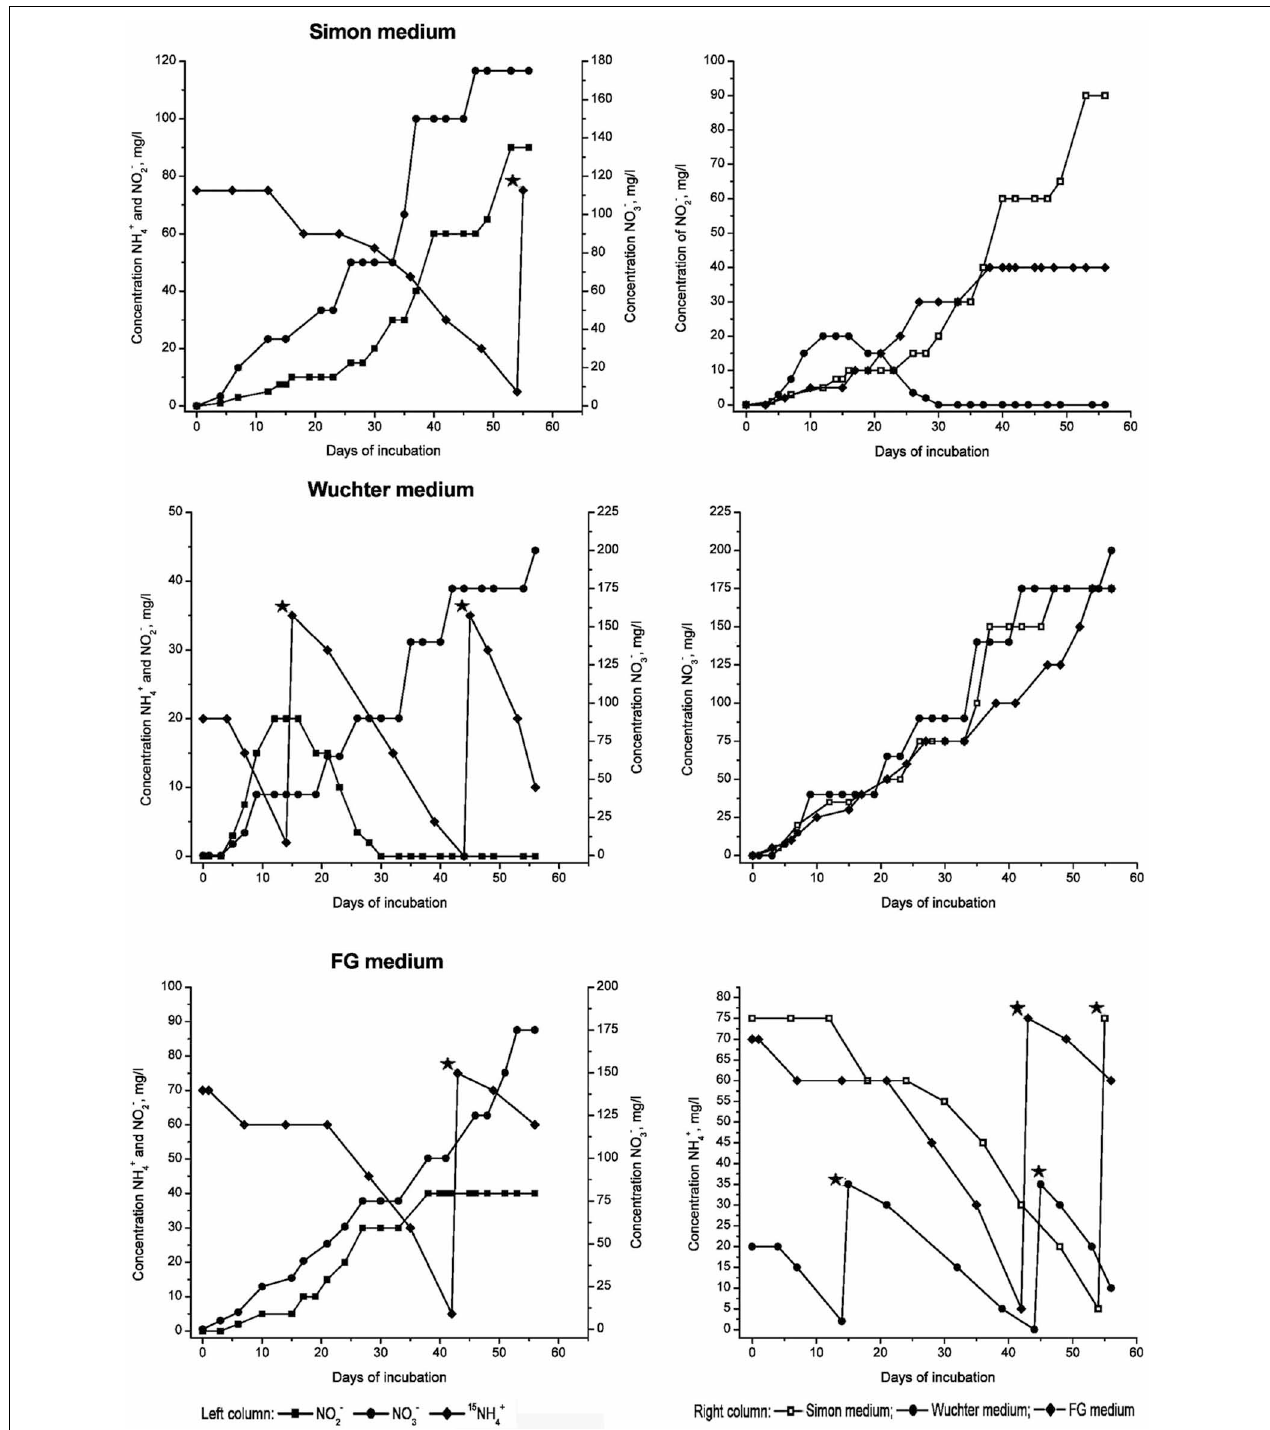
FIGURE 1 | Oxidation of ammonium and formation of nitrite and nitrate in microcosms, which were prepared with Simon, Wuchter, or FG medium, respectively, and labeled nitrogen compounds (left panels). The inoculum consisted of filtered (planktonic) microbes from the FJQ spring. Incubation temperature was 40 ◦ C. Substrates ( 15 NH 4 Cl